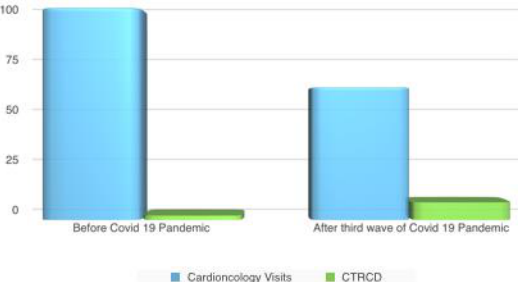
Figure 1. Number of Cardio-Oncology visits and CTRCD before and after COVID-19 Pandemic.